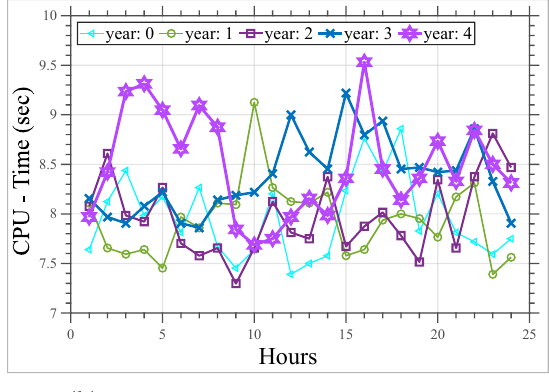
( b ) Machine time to solve secondary problem.